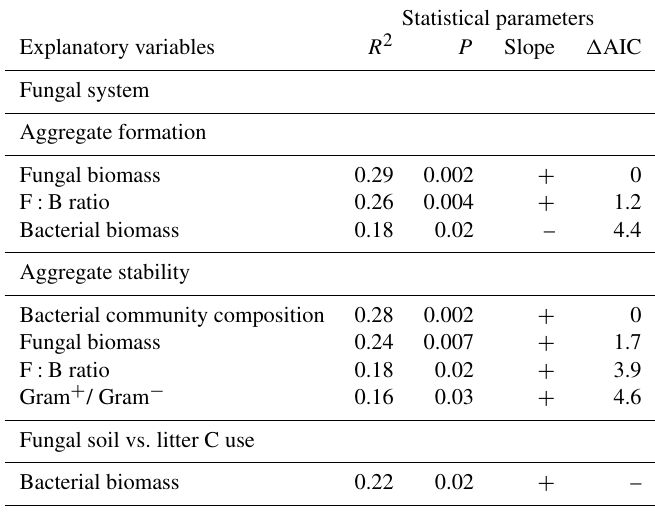
Table A3. Simple linear regressions between soil structure, C dynamics and descriptors of soil microbial community composition. Relation- ships were tested using simple generalized linear models (GLMs); only significant relations are